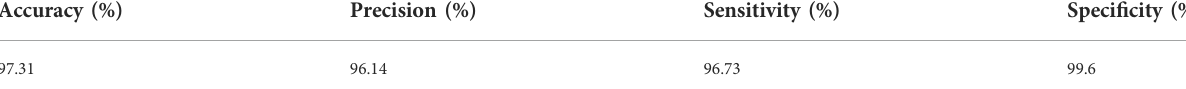
TABLE 3 Results of the second experiment.